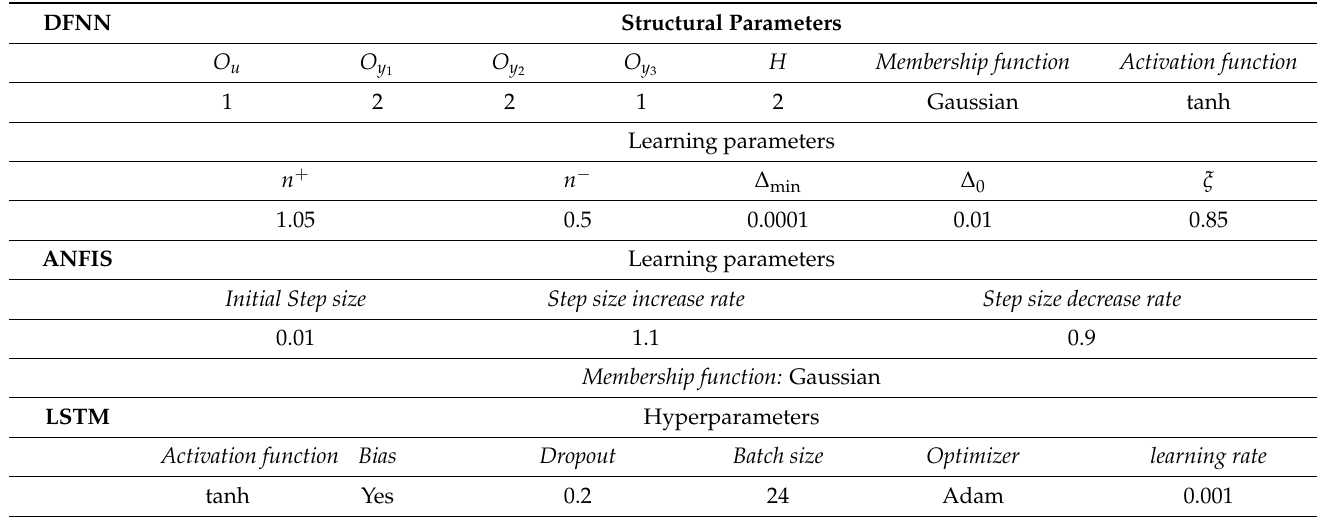
Table 6. Parameters of competing forecasters.